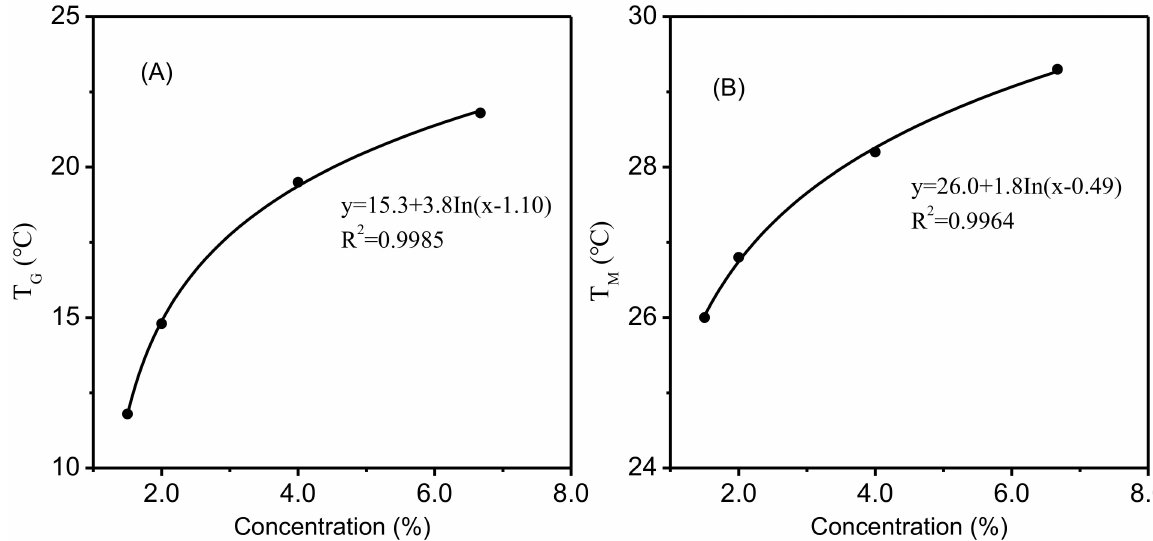
Figure 7. The relationship between gelatin concentration and T G ( A ), T M ( B